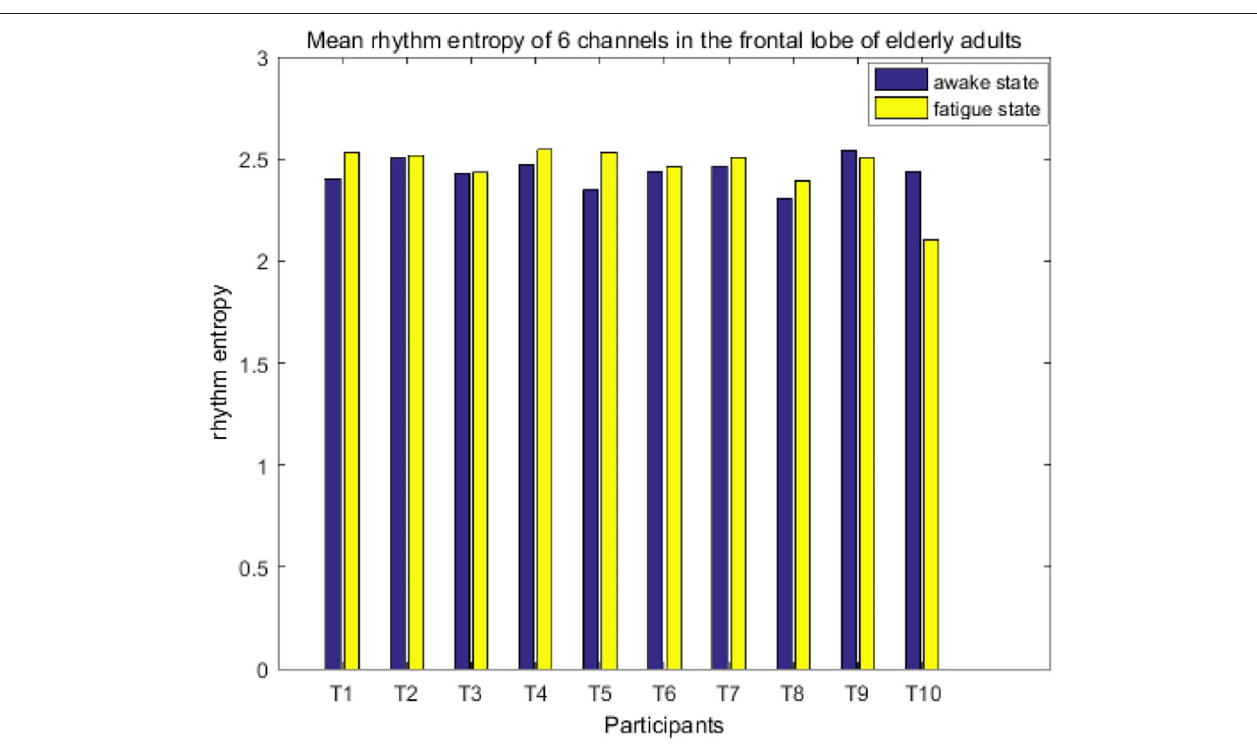
Frontiers in Aging Neuroscience |